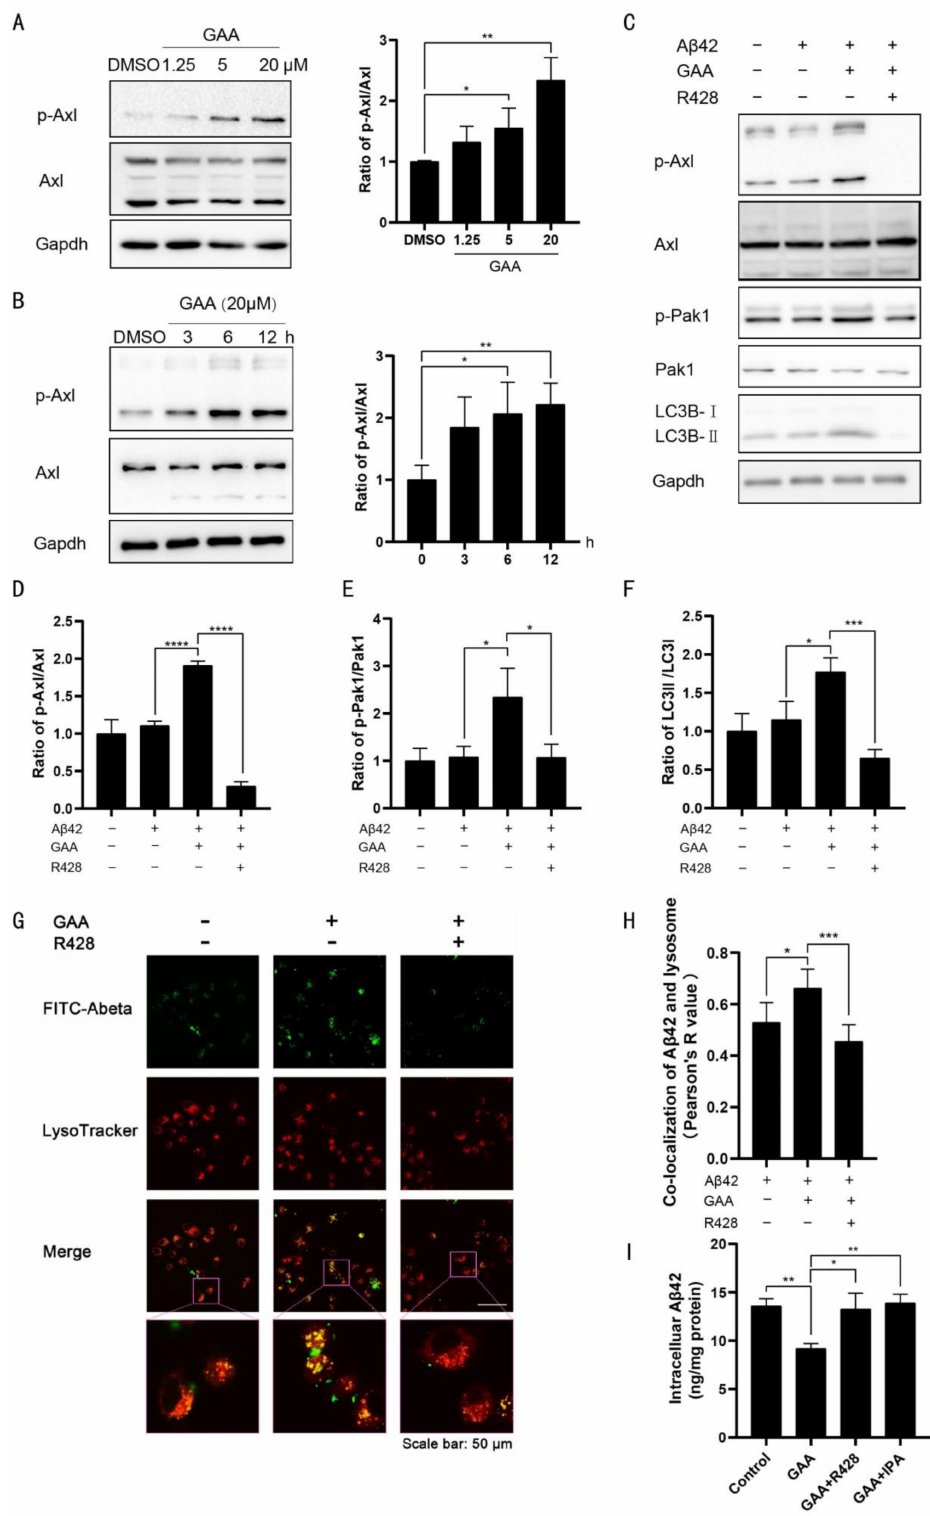
Figure 3. GAA activates the autophagy pathway through Axl. BV2 cells were ( A ) treated with GAA at the indicated concentrations for 6 h or ( B ) treated with GAA (20 µ M) for the indicated periods of time, and whole cell proteins were collected for Western blot. ( A ) GAA-5 vs. DMSO: p = 0.0452; GAA-20 vs. DMSO: p = 0.0034; n = 3. ( B ) 6 h vs. 0 h: p = 0.0299; 12 h vs. 0 h: p = 0.0073; n = 3. ( C – F ) BV2 cells were pretreated with 0.1% DMSO or the indicated Axl antagonist (R428 at 5 µ